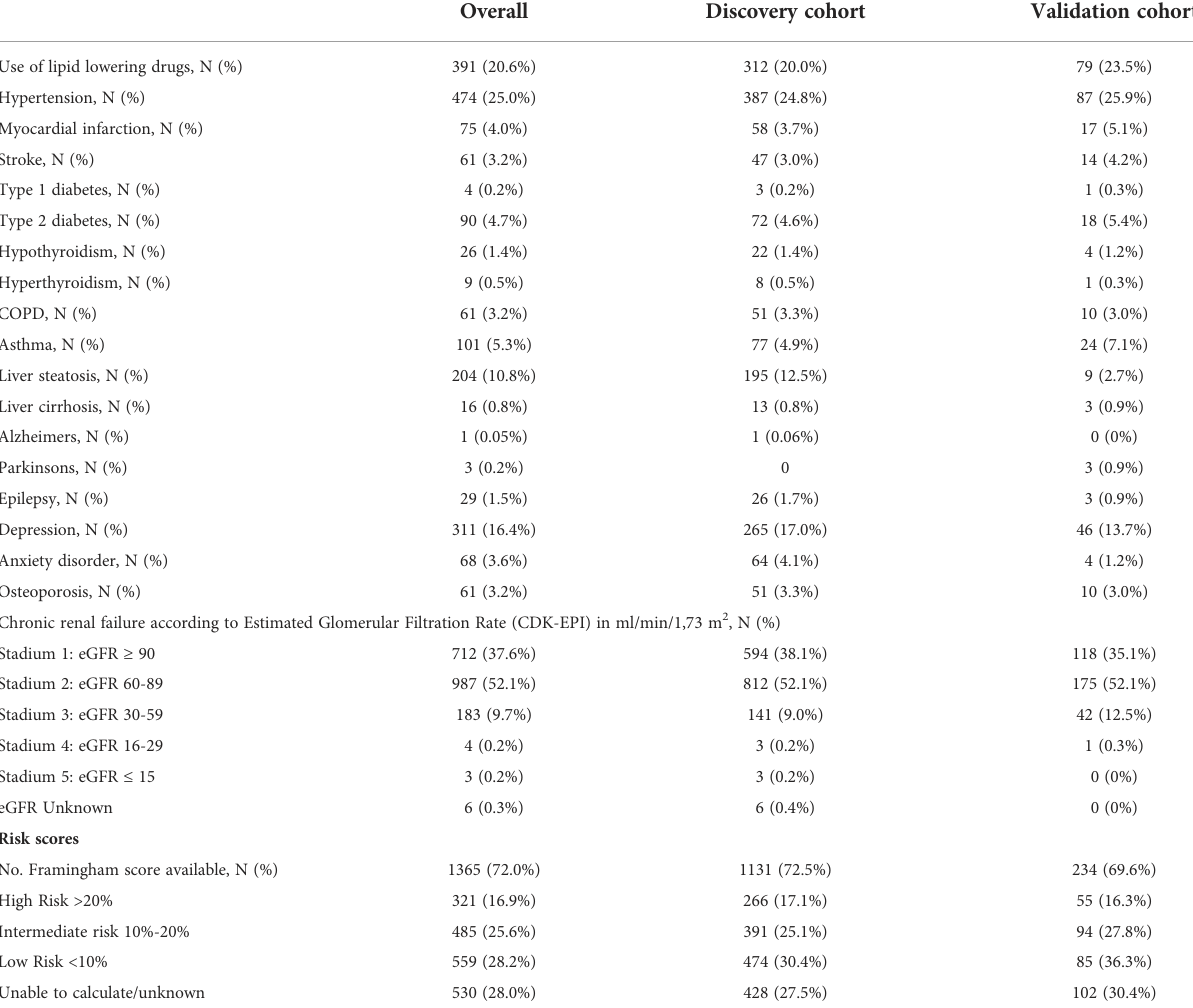
TABLE 5 Baseline previously recorded comorbidities in study